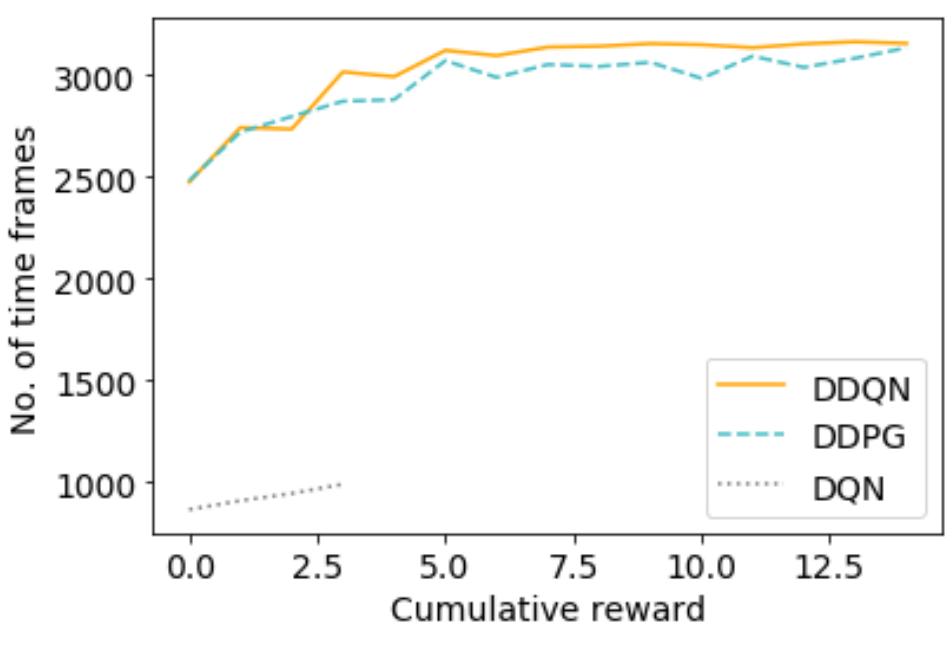
Figure 11. Cumulative Reward vs. No. of Time